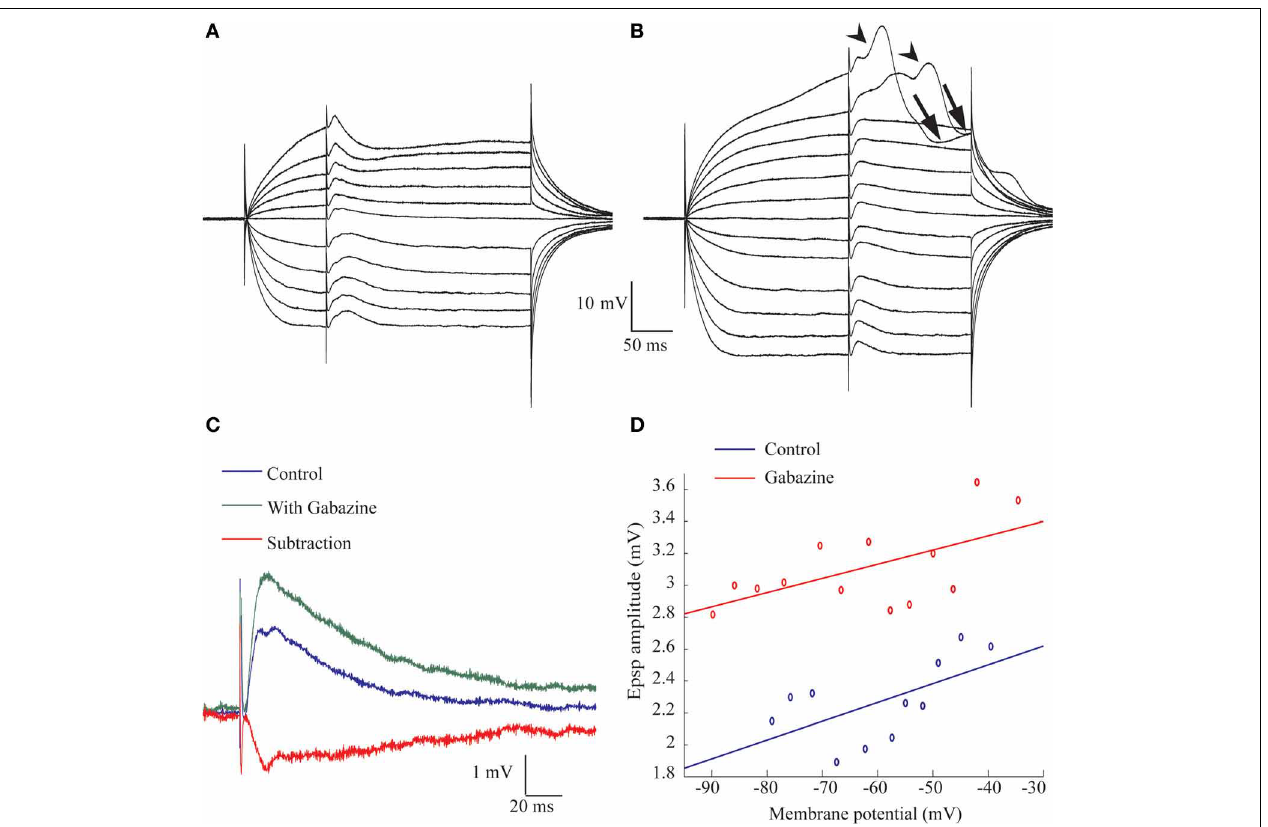
FIGURE 5 | Blocking GABAergic transmission reveal the excitatory response evoked by afferent nerve stimulation. (A,B) The voltage dependent of the responses to afferent nerve stimulation before (A) and after (B) application of 300nM gabazine. (C) Superimposed traces taken from (A,B) at rest membrane potential before (blue trace) and after (green trace)